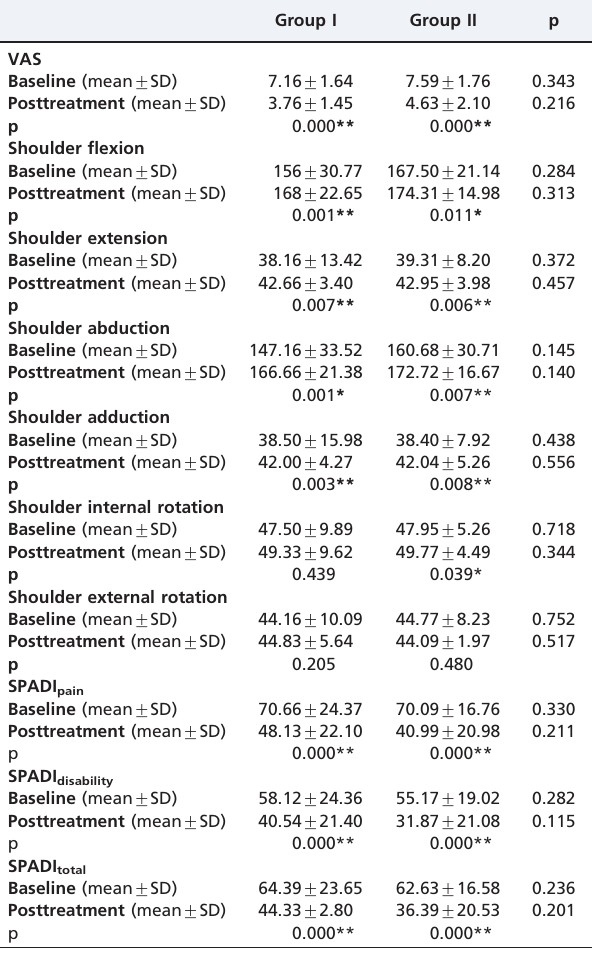
Table 2 - Comparison of mean values of pain severity, ROM and SPADI scores before and after the treatment between the